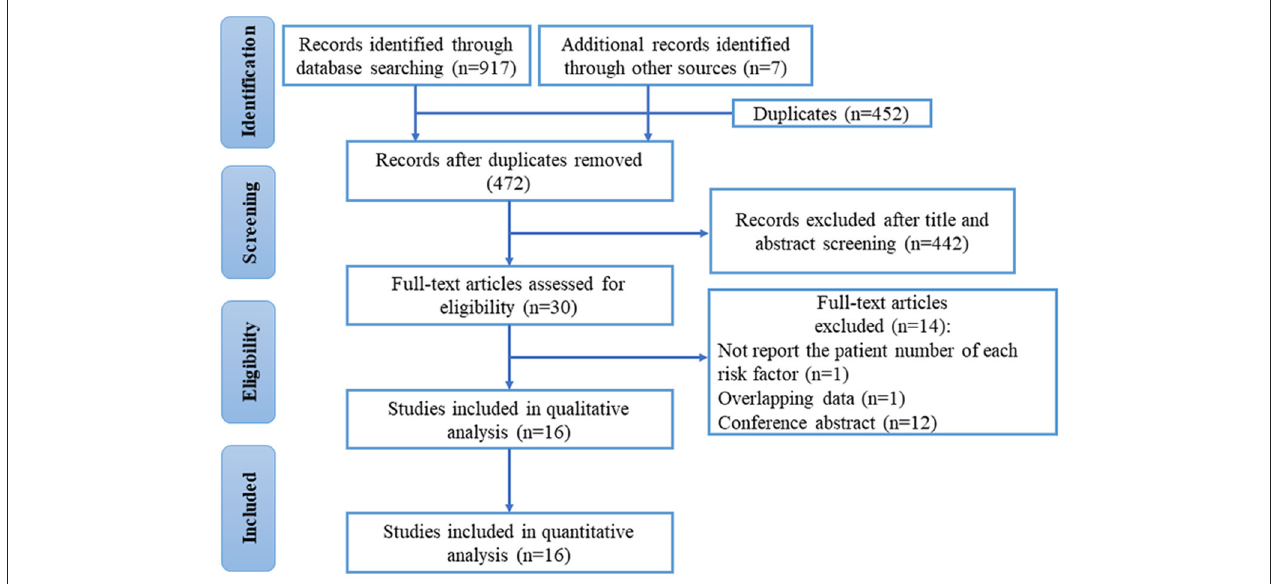
FIGURE 1 | Flow diagram for systematic review and meta-analysis.